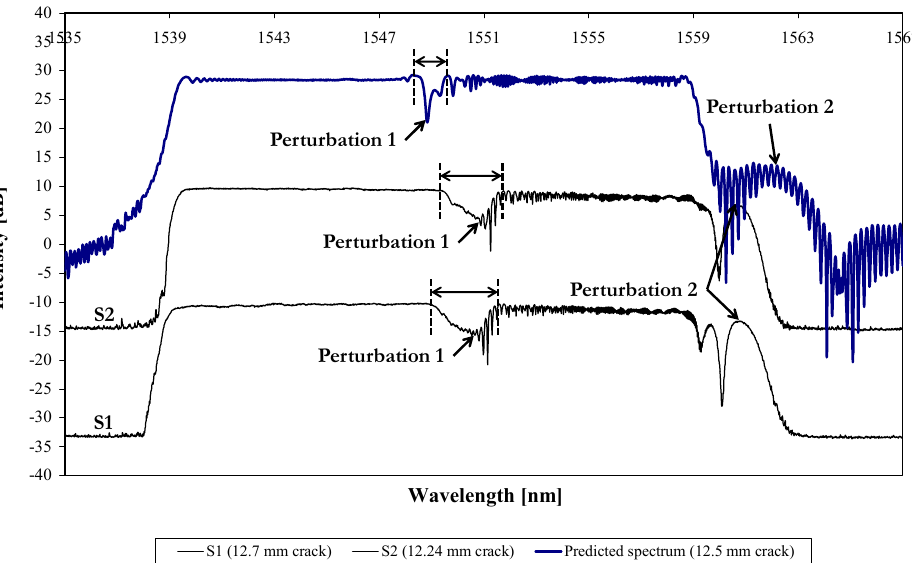
Figure 15. Recorded/predicted reflected spectra of the damaged specimens (S1 and S2) and damaged model loaded at 6 kN.